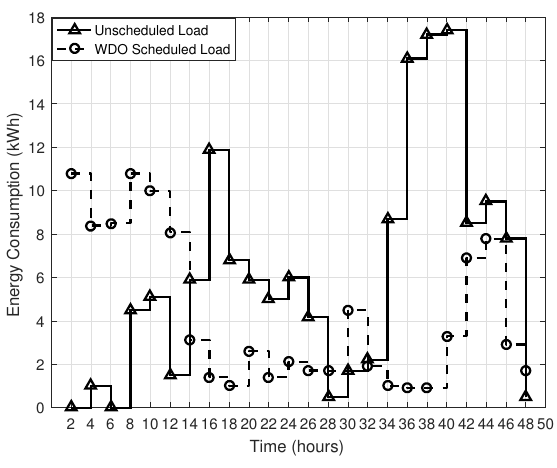
Figure 11. WDO energy